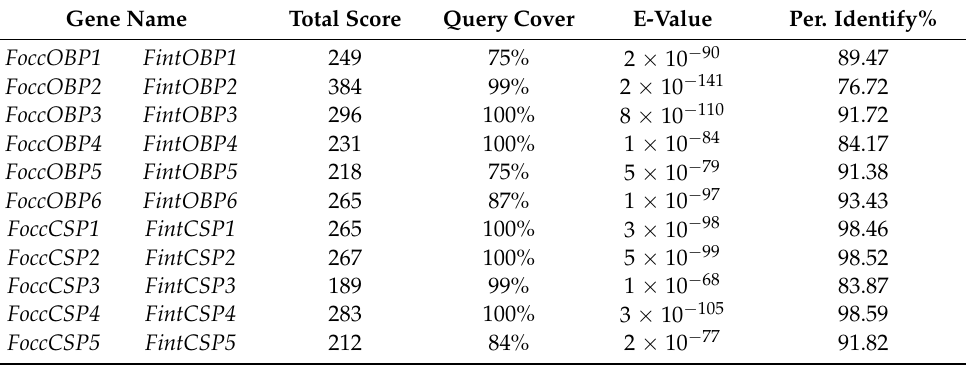
Table 2. Alignment of OBP and CSP protein sequences in Frankliniella occidentalis and Frankliniella intonsa